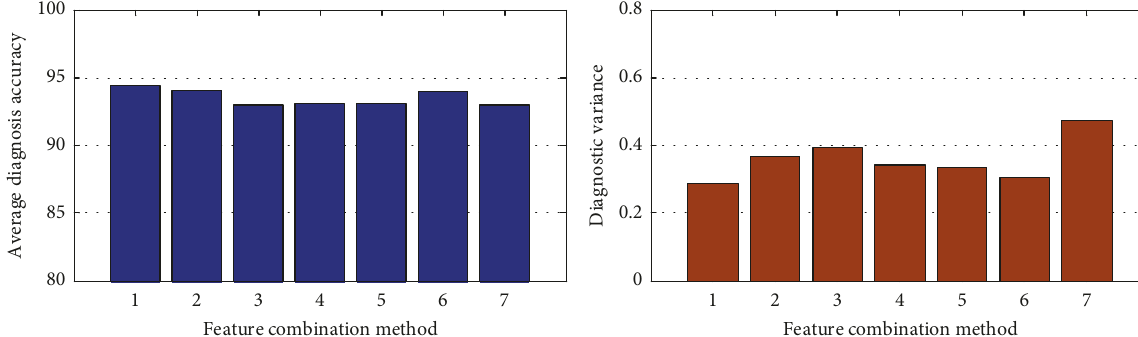
Figure 7: Fault diagnosis of hydraulic system under different combinations of features.